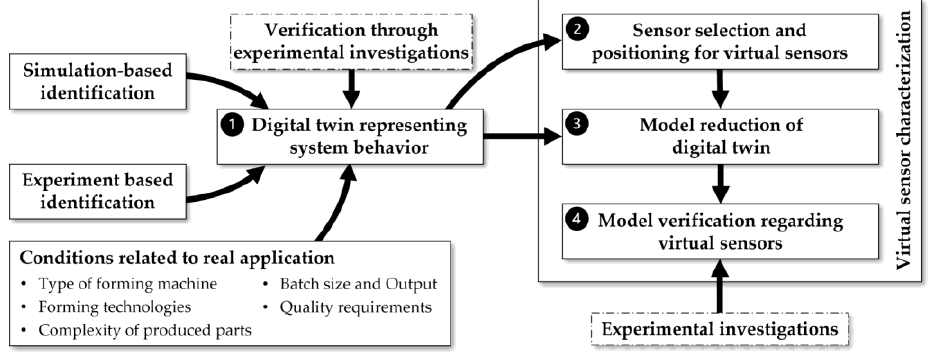
Figure 3. Methodical approach to create virtual sensors for complex forming systems based on the digital twin.